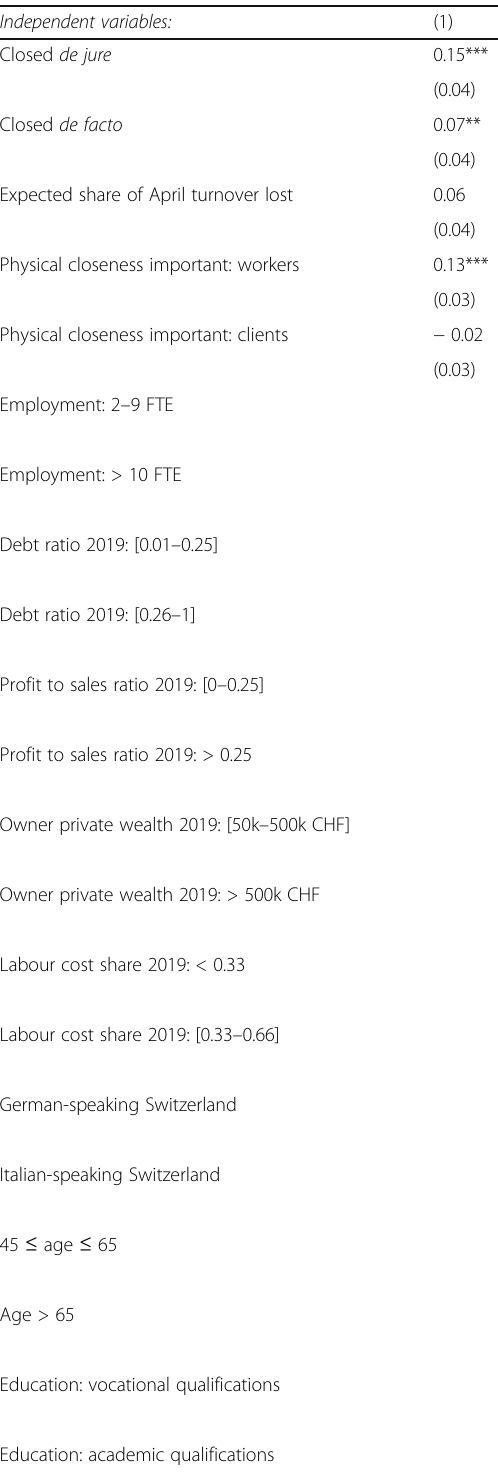
Table 4 Determinants of the use of corona